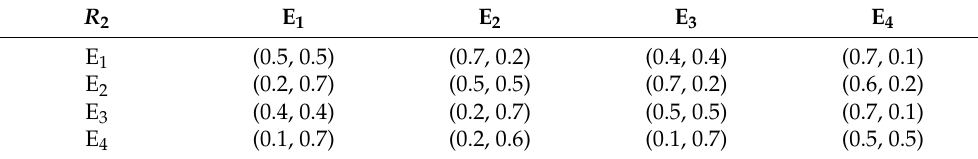
Table 11. The expert group’s intuitionistic-preference relationship for education level (C 2 ).